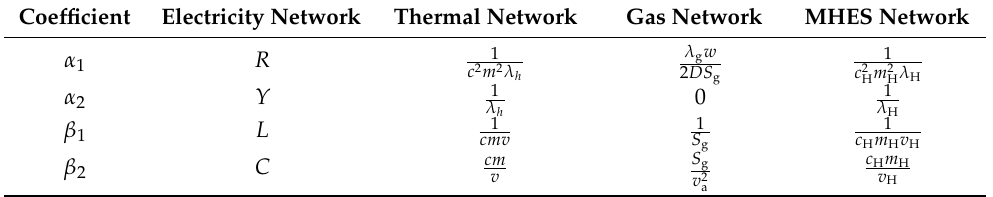
Table 2. Value of the correlation